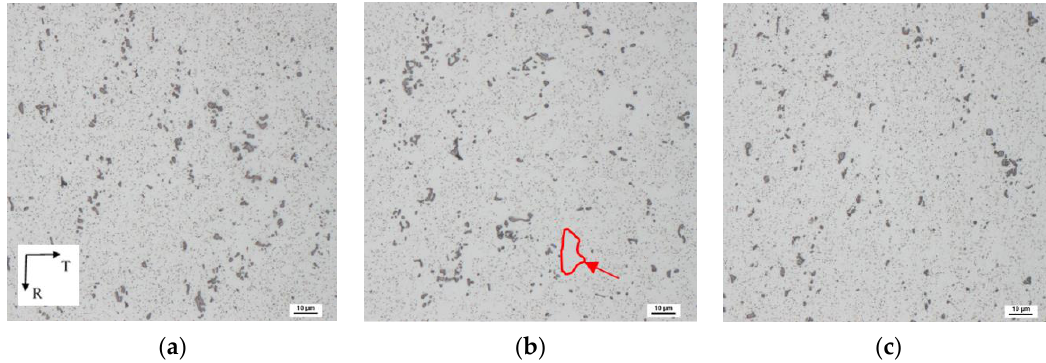
Figure 10. Electron micrographs of the ECS material taken from the TR plane: ( a ) upper and ( c ) bottom surface region; ( b ) central region. Dix – Keller etching was used.